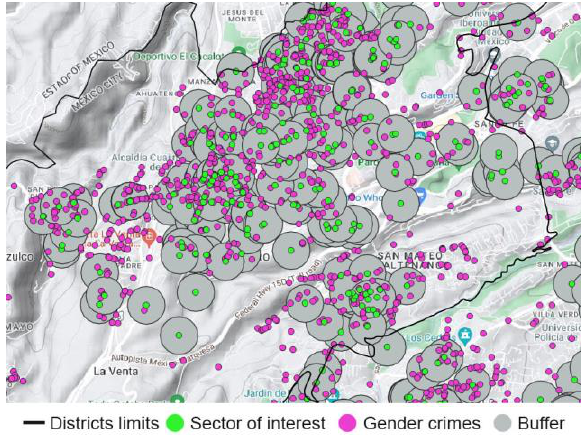
Figure 2. 2D analysis and model.